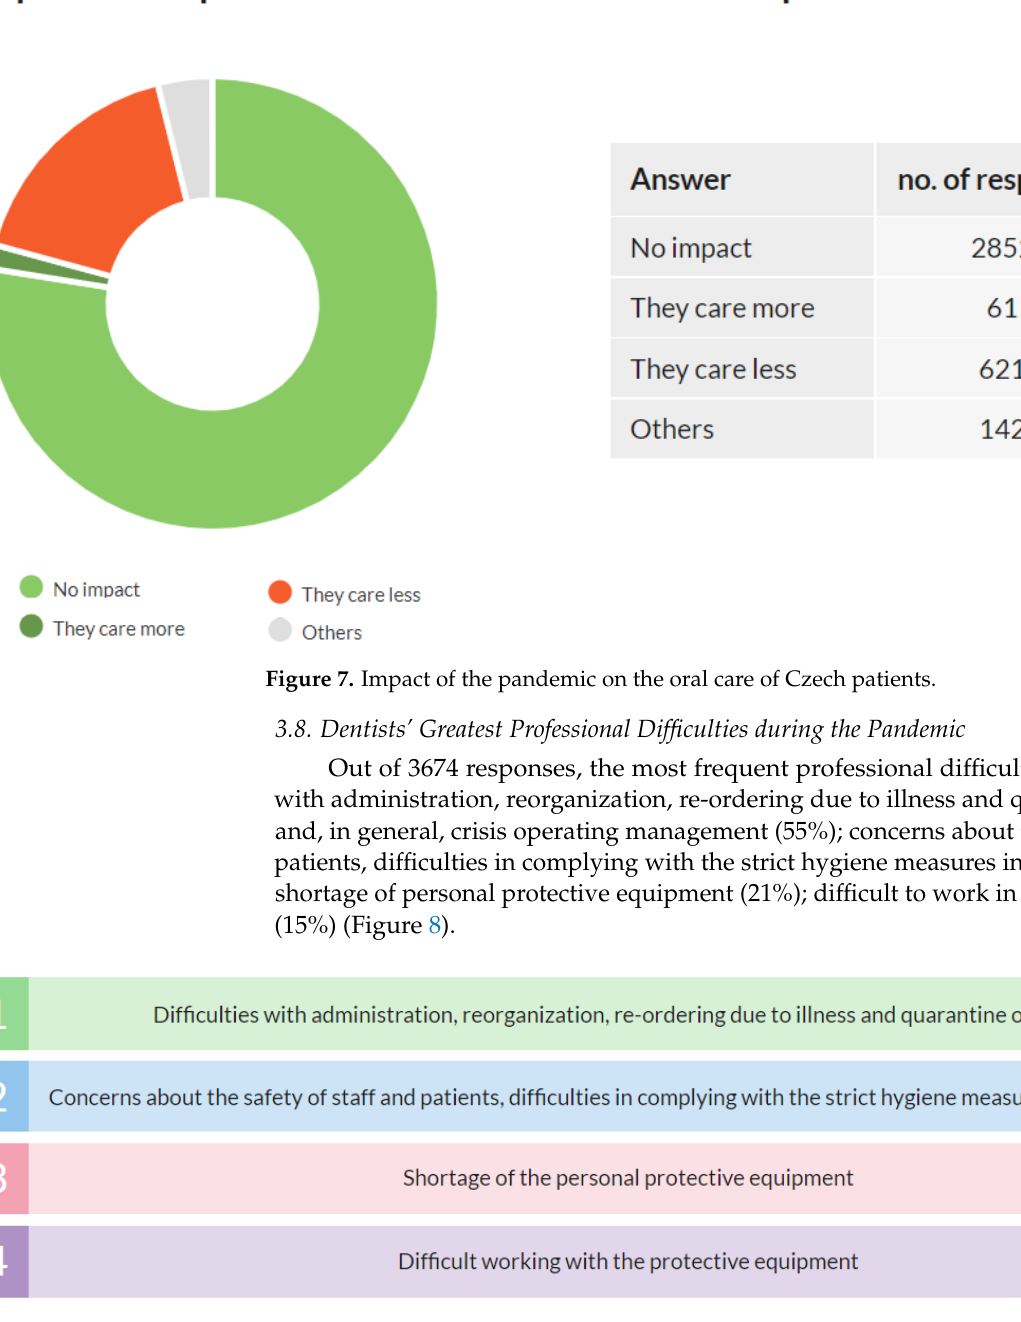
Figure 8. Czech dentists ’ greatest professional difficulties during the